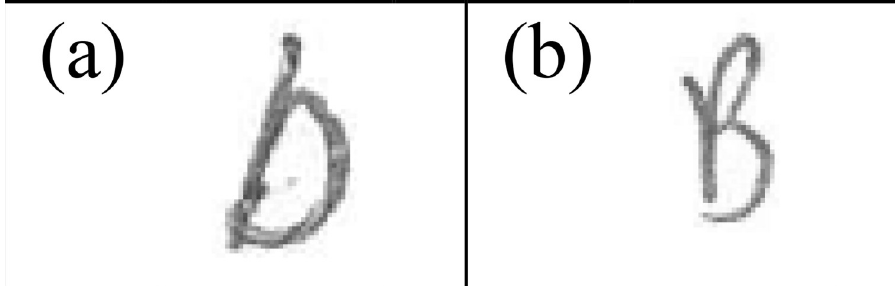
Fig 3. Characteristic handwritten allographic features from writers from National